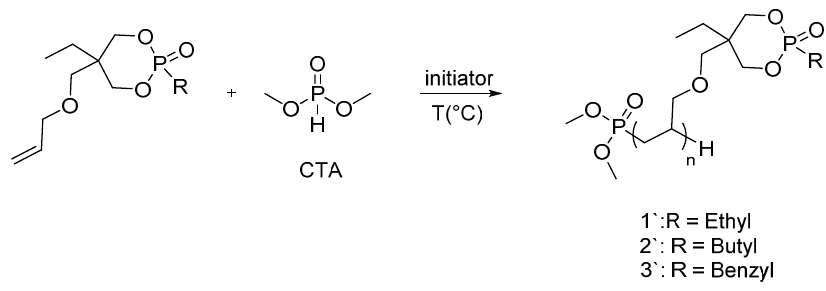
Figure 4. Radical polymerization of dioxaphosphorinane monomers, using dimethyl phosphite as CTA.